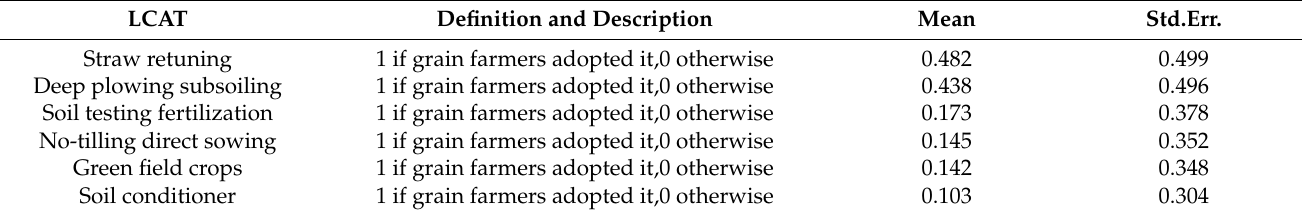
Table 1. Definition and Description of Six